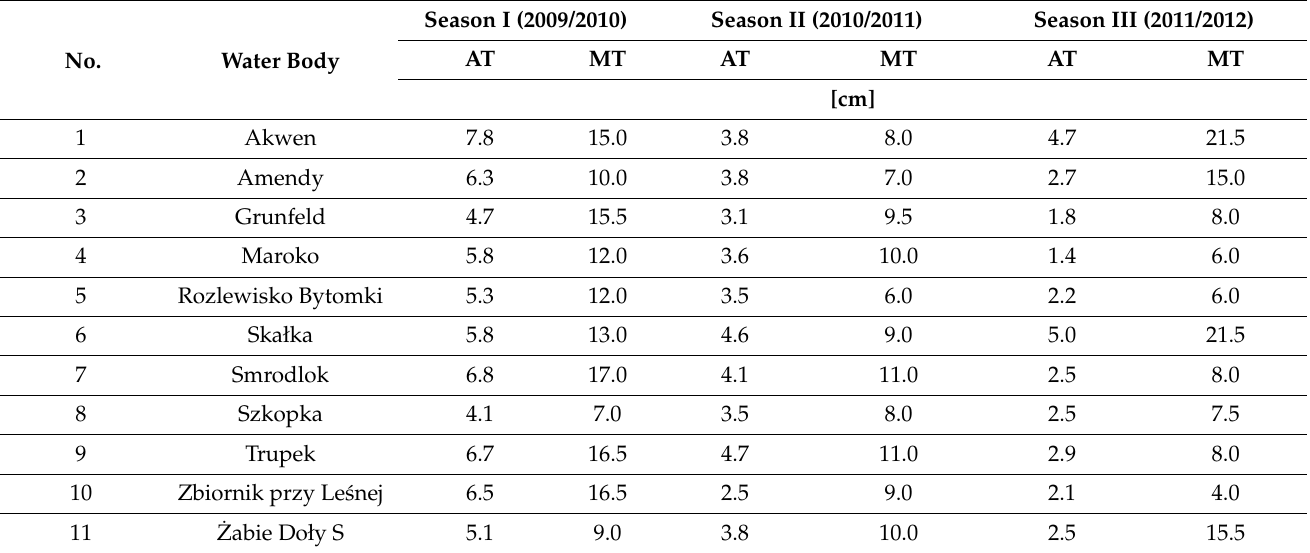
Table 2. Average (AT) and maximal (MT) snow cover thickness values on studied water bodies of Katowice Upland in the winter seasons of 2009/2010, 2010/2011, and 2022/2012 ([26]